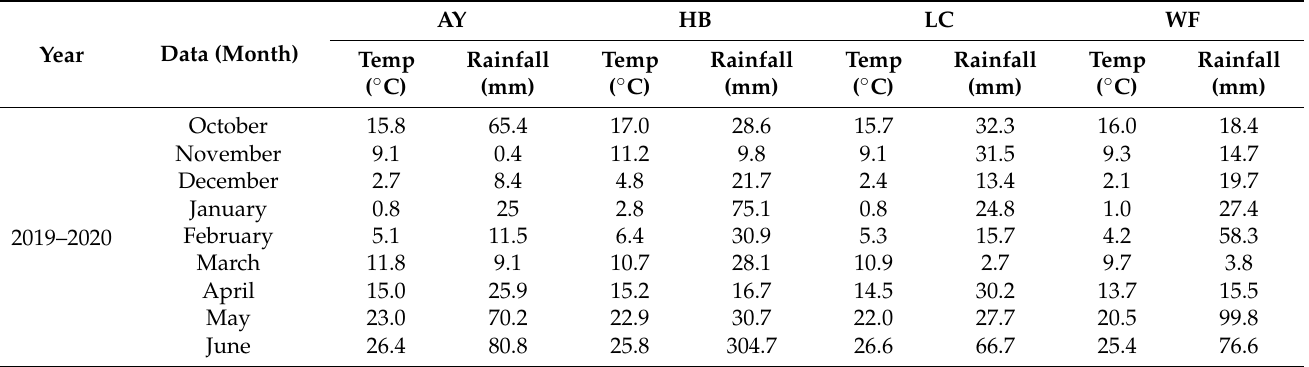
Table 2. Temperature and rainfall conditions during the growing season of wheat. AY: Anyang; HB: Huaibei; LC: Liaocheng; WF: